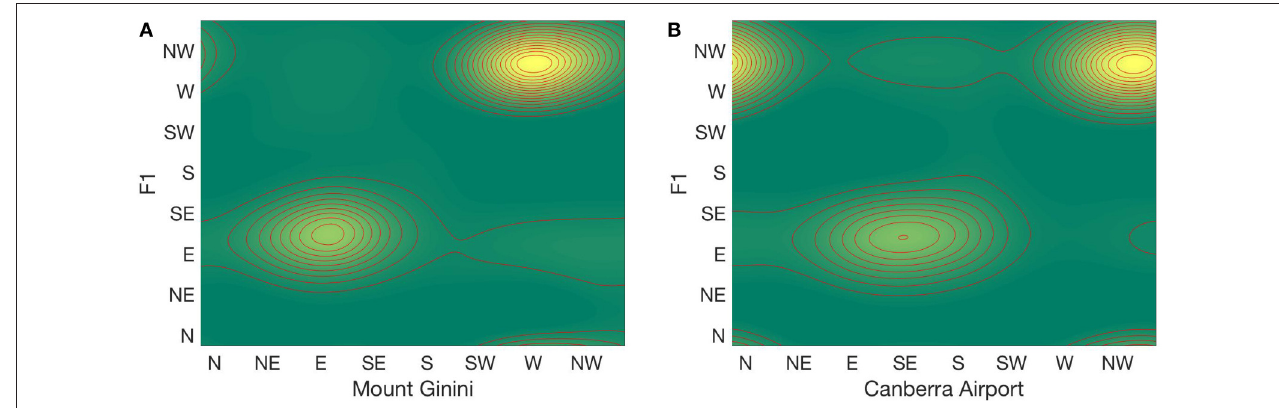
FIGURE 4 | Joint wind direction distributions between F1 and (A) Mount Ginini and (B) Canberra Airport during the study period. Yellow coloring indicates higher frequency of wind direction pairs observed. Dotted line indicates equal wind direction at the two